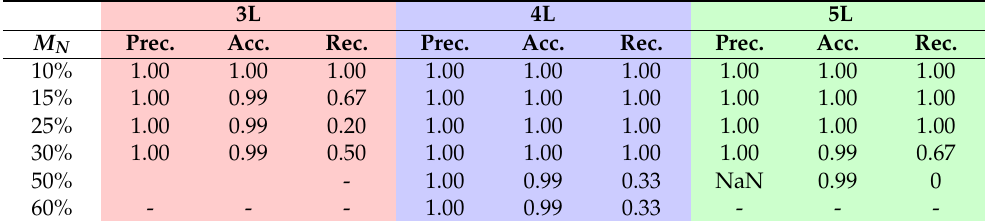
Figure 11. The ROC of various attack scenarios considering measurements noise levels. Table 4. Attack 1 detection results considering measurement noise.